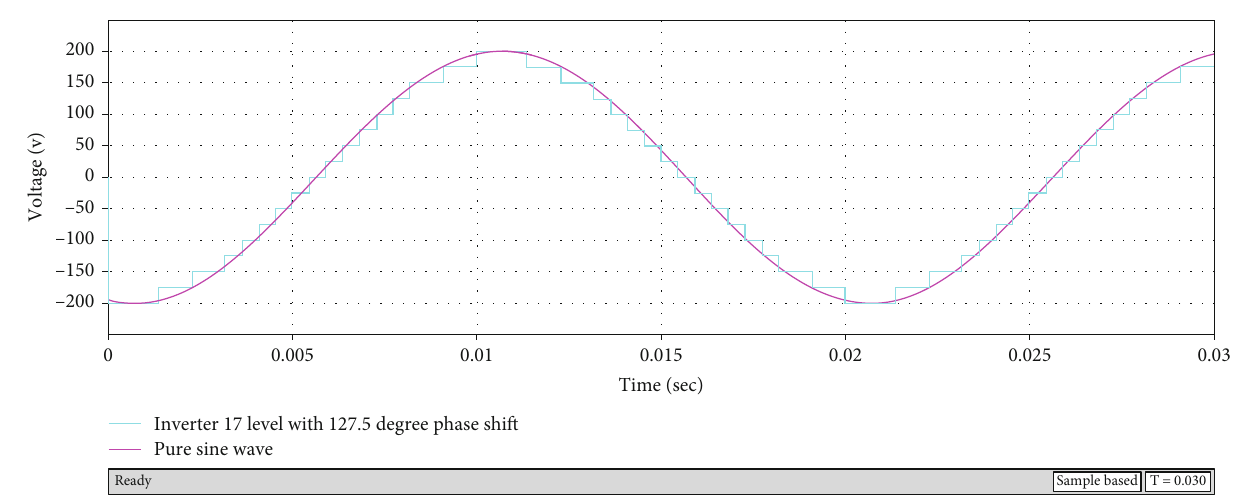
Figure 32: 17-level MLI with t = 0 : 03 for phase c.